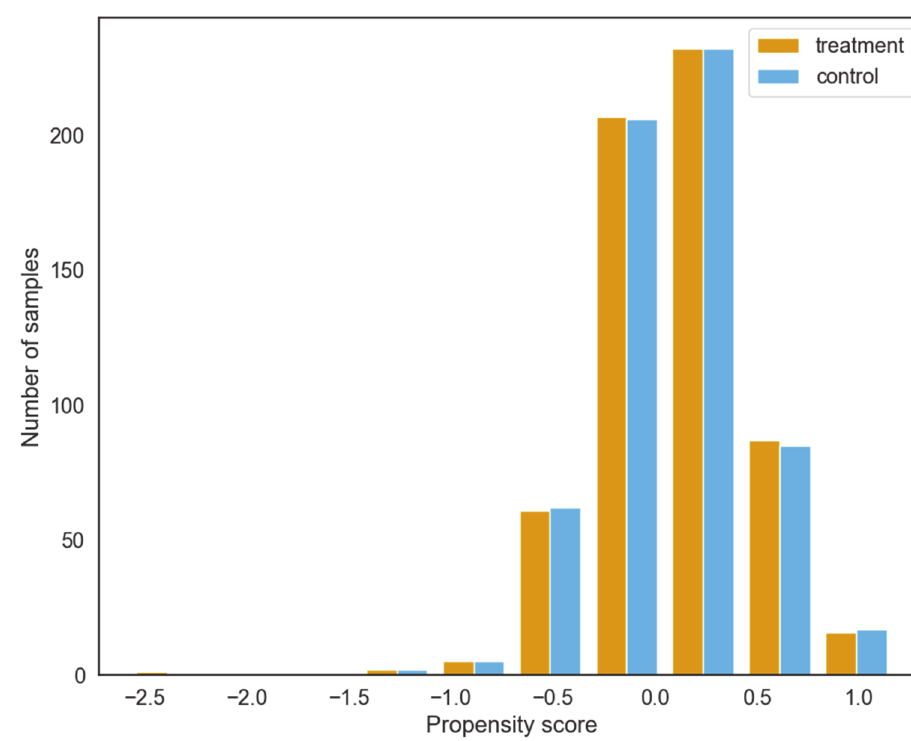
Figure 3. Propensity score distribution of treatment and control.